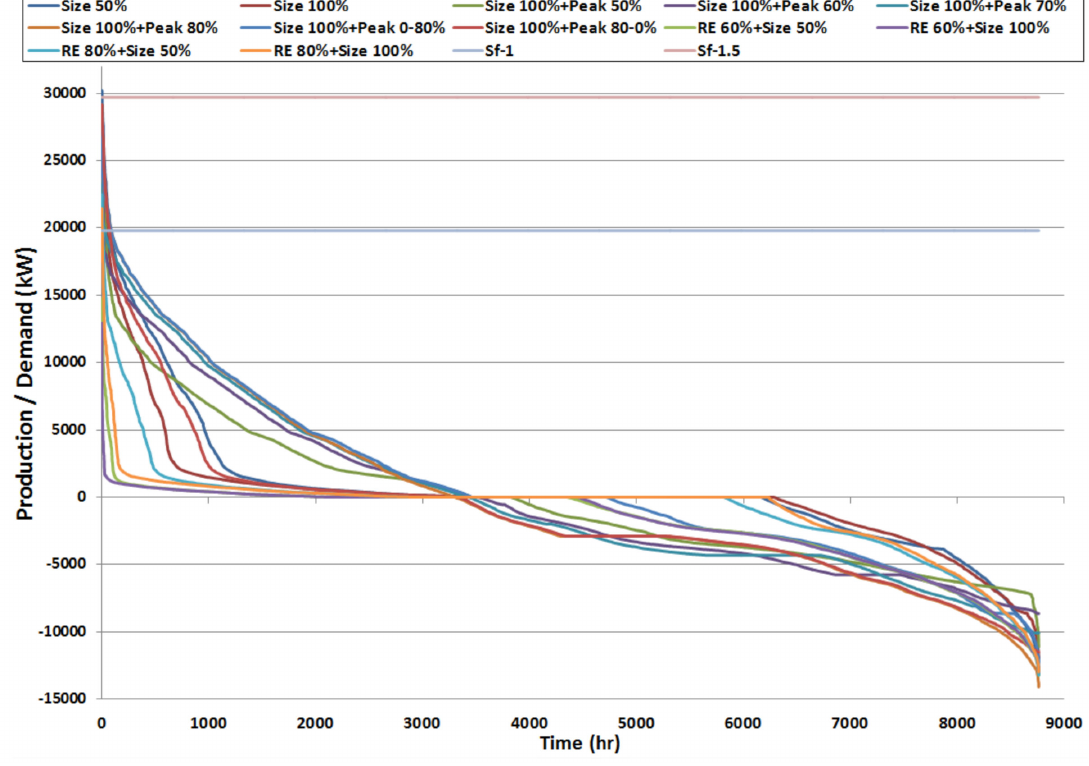
Figure A12. Main LDC results from the lowered RE production scenarios. (6) Increased biomass potential scenarios combined with lowering RE production The following scenarios are used to indicate the effect of increasing the biomass availability in the average municipality in combination with lowering RE production (Table